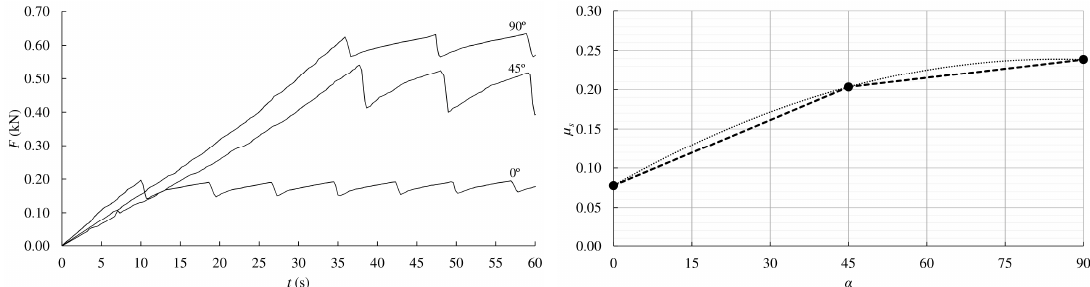
Figure 8. Timber-to-timber friction coefficient vs. time for 0°, 45°, and 90° grain orientations ( left ); variation of mean friction coefficients with respect to grain orientations ( right ).